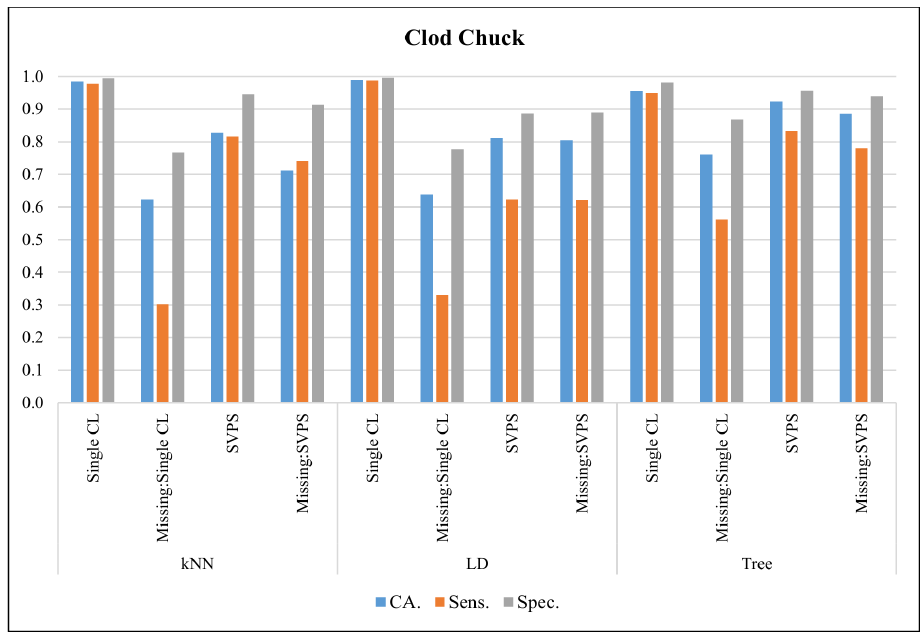
Figure 10. Classification results for Clod Chuck dataset.